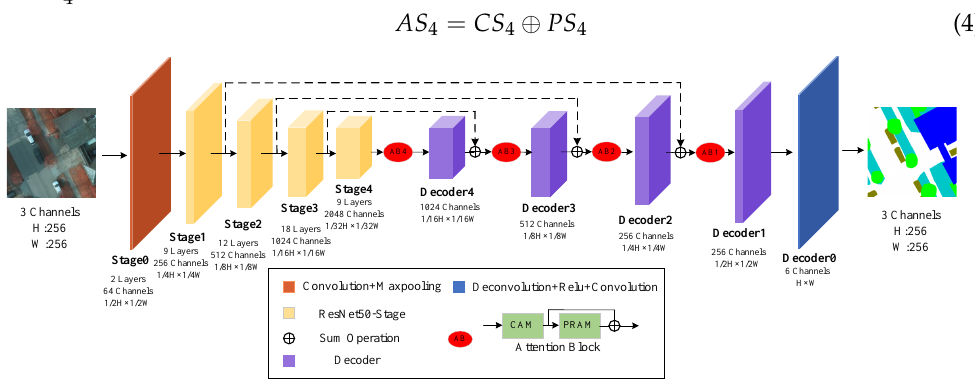
Figure 1. Flowchart of the proposed